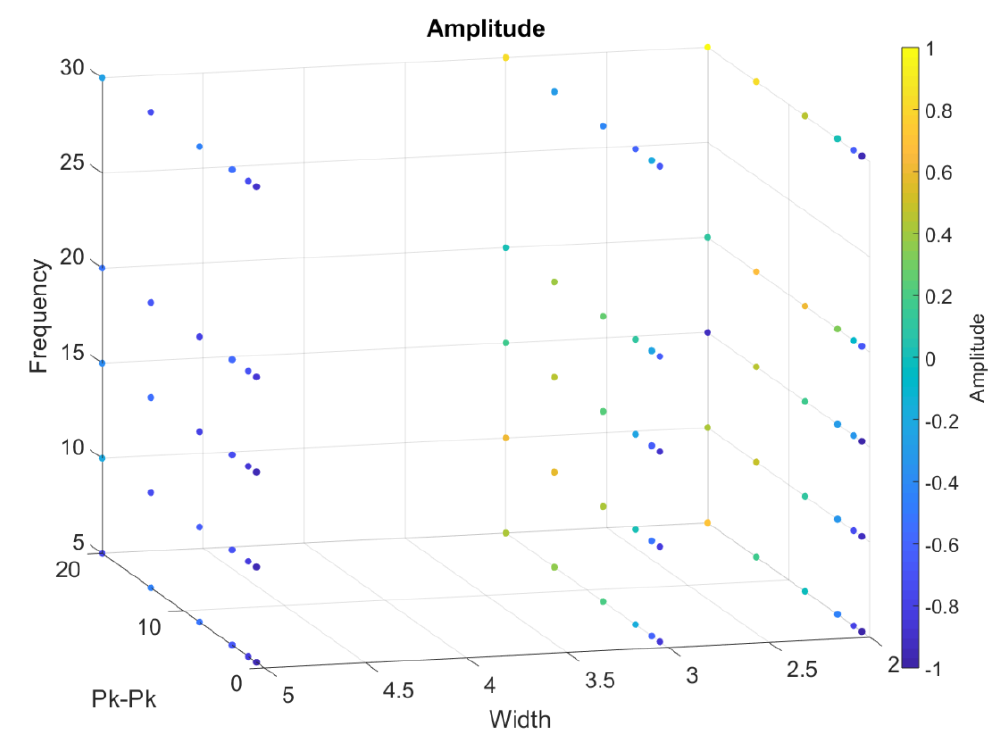
Figure 22. A 3D scatter plot for